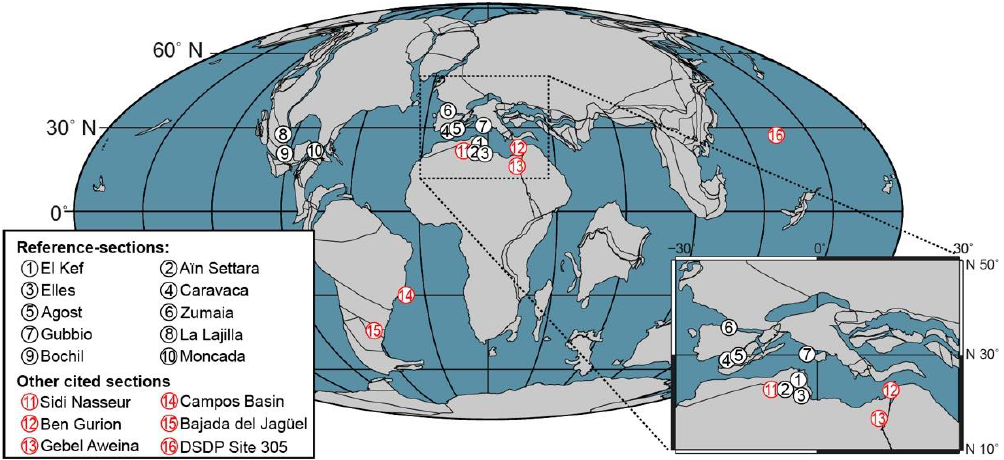
Figure 1. Paleogeographic reconstruction for the KPB (66 Ma), with the localities cited in this study (after https://www.odsn.de/odsn/services/paleomap/adv_map.html (accessed on 3 July 2021)).